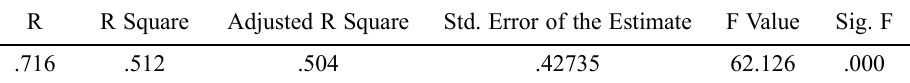
Table 3. Aggregate effect of the seven independent variables on affective commitment R R Square Adjusted R Square Std. Error of the Estimate